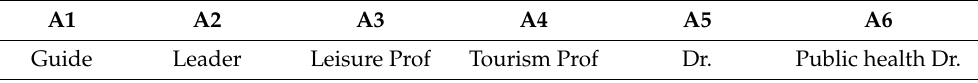
Table 2. Background analysis and topics of the